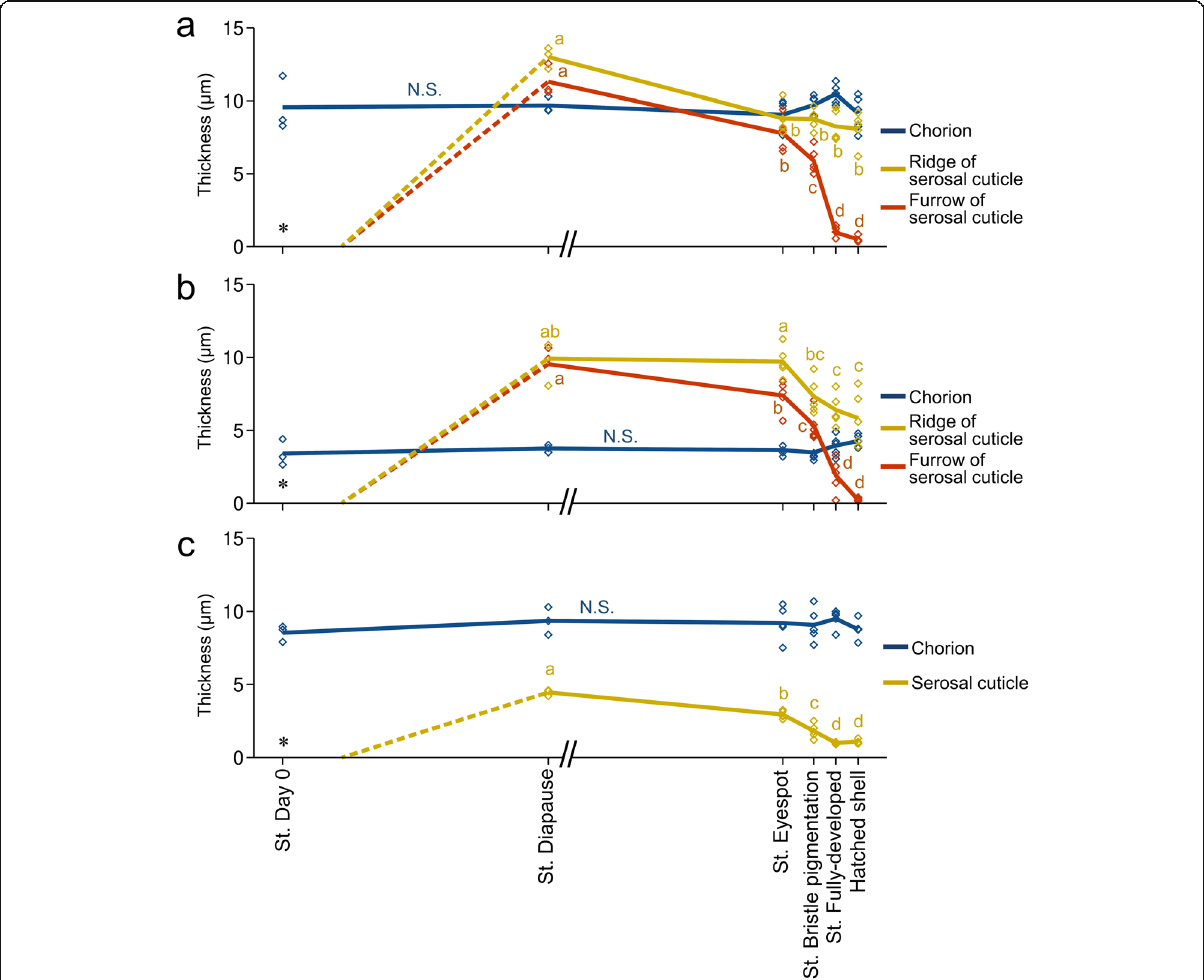
Fig. 5 Developmental changes in eggshell thickness during embryogenesis. The thickness of the chorion and the serosal cuticle was measured on the dorsal hatching line 180 – 200 μ m ( a ) or 600 – 620 μ m ( b ) from the tip or at a lateral non-hatching-line site 180 – 200 μ m from the tip ( c ). The horizontal axis indicates stages of embryonic development with a scale reflecting typical developmental time (see Fig. 4a), except that the period of low temperature needed for diapause termination is not included (//). Lines connect the mean values of each point in development, and diamonds show individual values ( N = 3 – 5). No serosal cuticle was present on Day 0 (*). Although the cuticle layer became recognizable at approximately Day 15 – 20, we did not quantify the thickness change until the start of diapause (broken line). Different letters indicate statistically significant differences among developmental stages (likelihood ratio test of a generalized linear model, P < 0.05), while N.S. indicates no significance ( P >